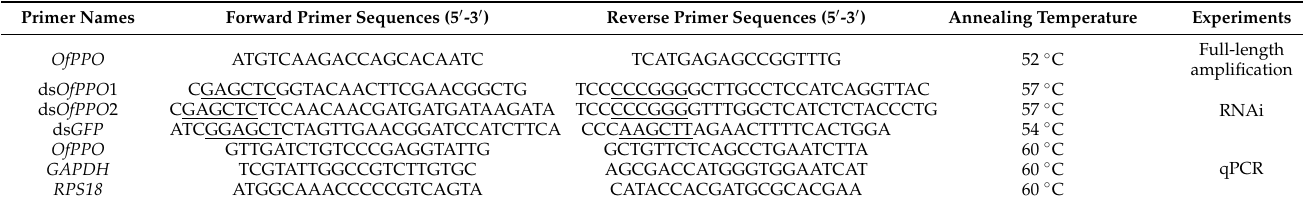
Table 2. Primers used for this